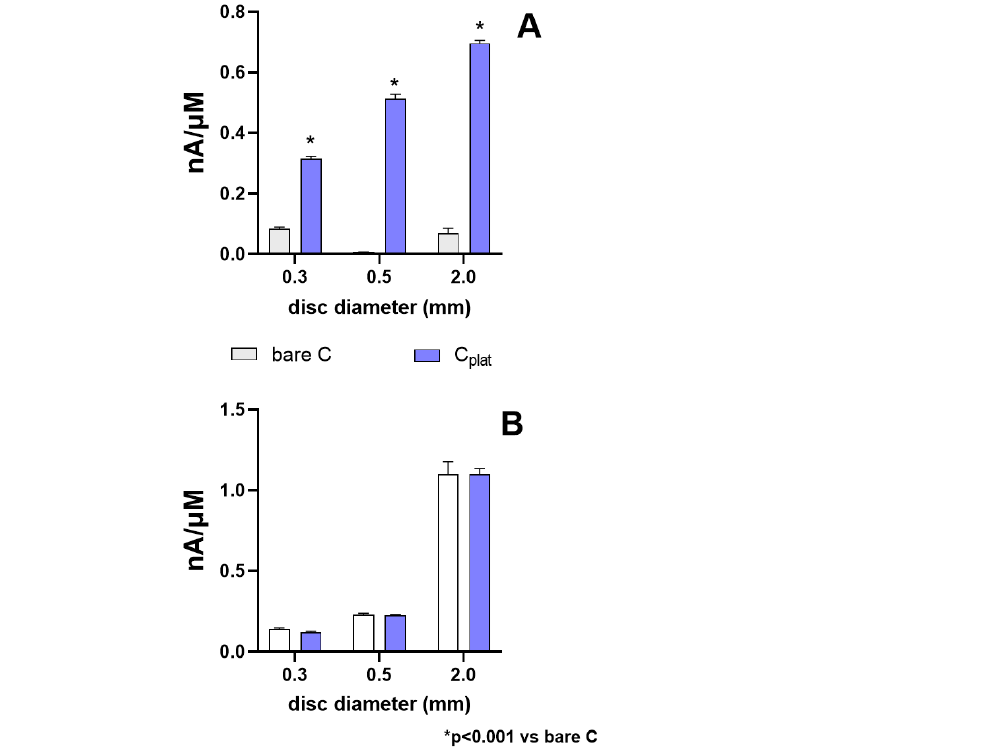
Figure 5. HP (Panel ( A )) and AA (Panel ( B )) monitoring on different diameter pencil leads (0.3, 0.5 2.0 mm). Slopes are given as nA/ µ M ± SEM; n = 4; * p < 0.001 vs. bare C. In Panel B, data from AA calibration are displayed. Surprisingly, contrary to what happened with the CCRs, on all PLs, the platinization did not produce any statistical difference on AA monitoring if compared to the respective bare C values. In general, AA monitoring increased, in parallel to the increase in the diameter of the